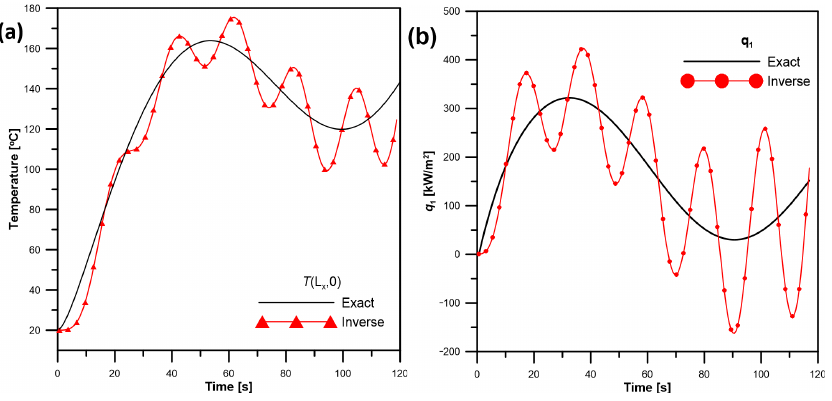
Figure 8. Instability of the inverse solution: temperature history in point ( L x ,0) ( a ), heat flux q 1 ( b ). Additionally, the method based on the LMA algorithm is tested [9,10]. This procedure allows for the use of ANSYS Multiphysics software [29]. Temperature measurement points have to be moved to TC 1 (11 L x /12, L y /2) and TC 2 (2 L x /3, 15 L y /16) to obtain a stable solution. The appropriate temperature changes are generated by the direct method. The number of future steps must also be increased to N F = 10. Despite all these actions, the errors and computation time are much higher than in the AMI and MMAI methods.